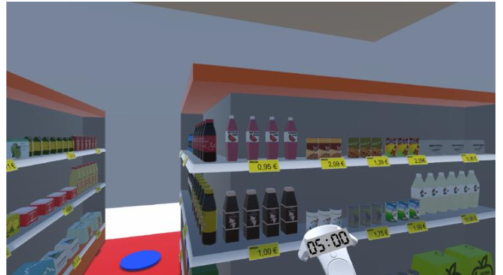
Figure 4. The virtual store and the shelves are shown in the picture. The remaining time on the controller can be seen in the image.